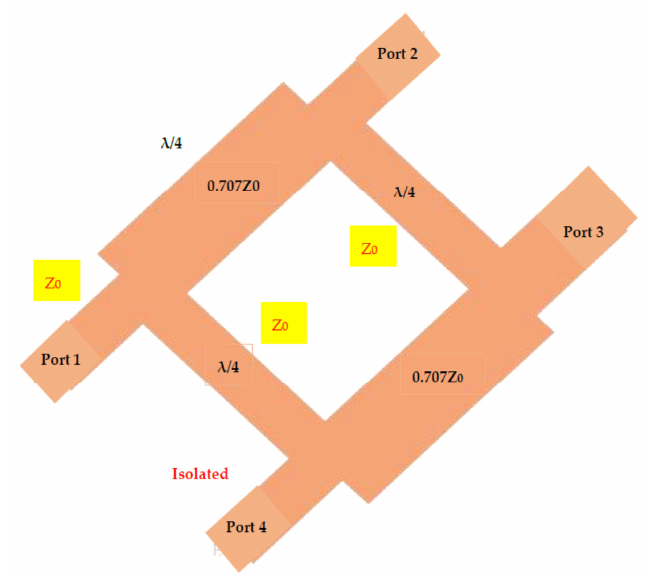
Figure 4. Layout of the −3 dB branch line coupler. Table 3. Branch line coupler design.